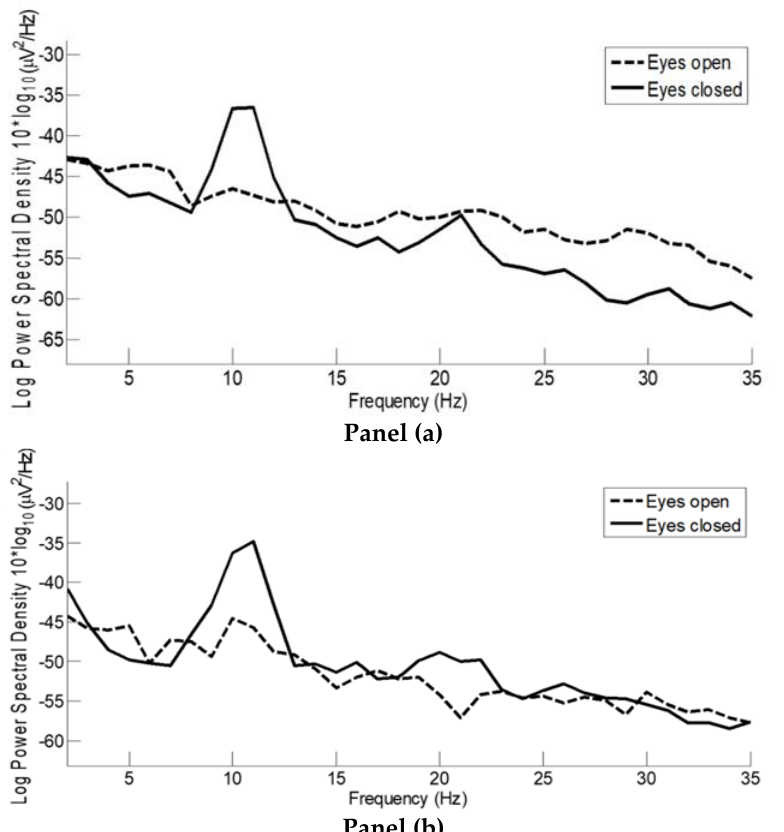
Figure 7. Alpha wave test. Both panels compare 20 s of data selected as artifact-free for the same electrode (very close to the standard 10–20 O1 position) for both eyes open (dashed bold line) and eyes closed (solid bold line). Panel a : data recorded using the onboard Driven Right Leg (DRL), power of alpha increase of 1.30 [10log 10 ( µ V 2 /Hz)/10log 10 ( µ V 2 /Hz)] times with respect to the baseline; panel b : data recorded using direct grounding with the inline protection resistor, power of alpha increase of 1.31 [10log 10 ( µ V 2 /Hz)/10log 10 ( µ V 2 /Hz)] times, with respect to the